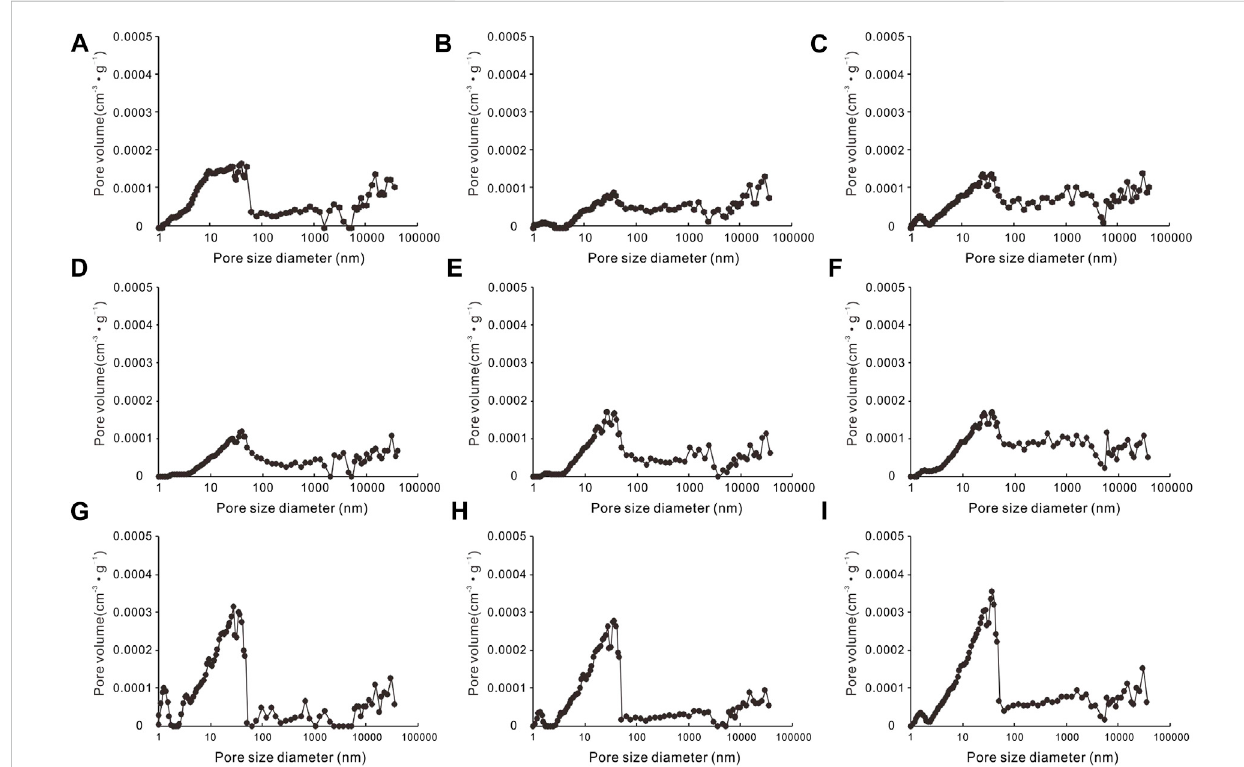
FIGURE 8 Pore-sizedistributionwithMICPandLTNAforJurassicLianggaoshanFormationlacustrineshaleindifferentlithologycombination. (A) TypeAshale, Well A, 2161.25 m; (B) Type A shale, Well B, 2455.06 m; (C) Type A shale, Well C,1896.18 m; (D) Type B shale, Well D, 2437.33 m; (E) Type B shale, Well B, 2452.29 m; (F) Type B shale, Well E, 1751.71 m; (G) Type C shale, Well A, 2164.49 m; (H) Type C shale, Well D, 2447.33 m; (I) Type C shale, Well E,1750.73